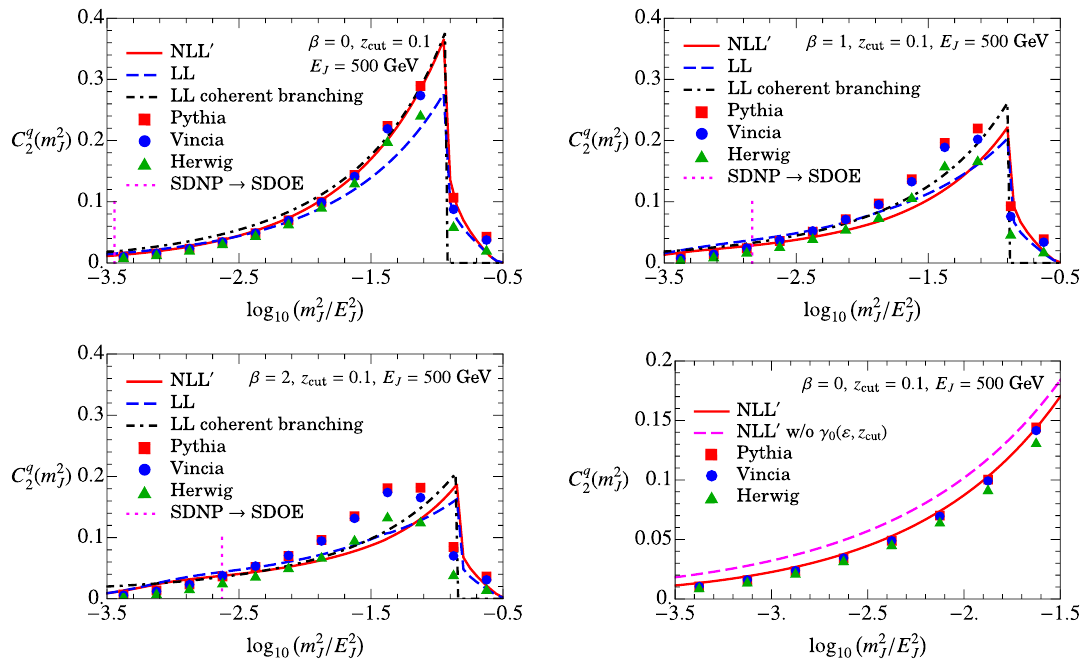
Figure 11 . Comparison between the NLL 0 / LL effective theory predictions for the perturbative coefficient C 2 (red/blue dashed), the analogous predictions from coherent branching formalism (black dotdashed) and Monte Carlo simulations (colored markers). The last panel shows the impact of the additional anomalous dimension γ 0 ( ε, z cut ) present in the boundary distribution in the case β = 0 , where we zoom on the range of validity of our